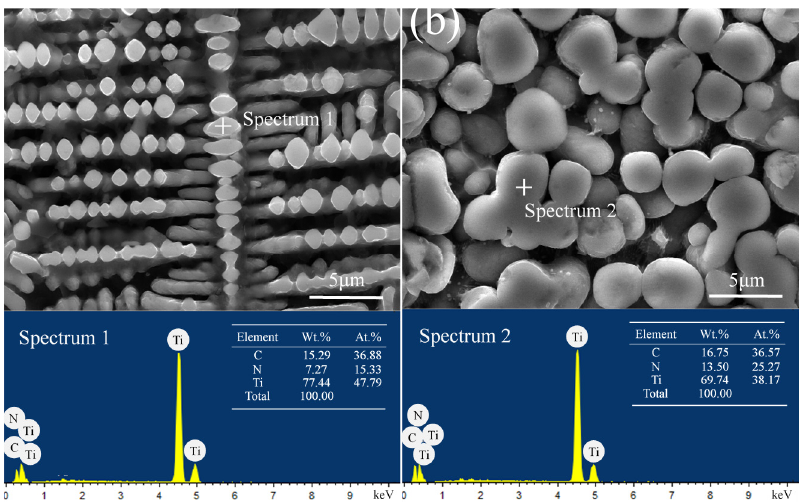
Figure 6. The EDS results of the typical grains in the coatings ( a ) without CeO 2 and ( b ) modified with CeO 2 .